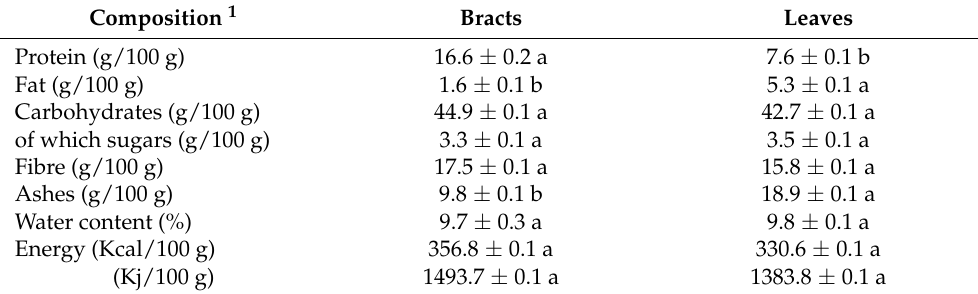
Table 5. Nutritional label and energy value for the discarded bracts and senescent leaves of the artichoke Bianco of Pertosa.